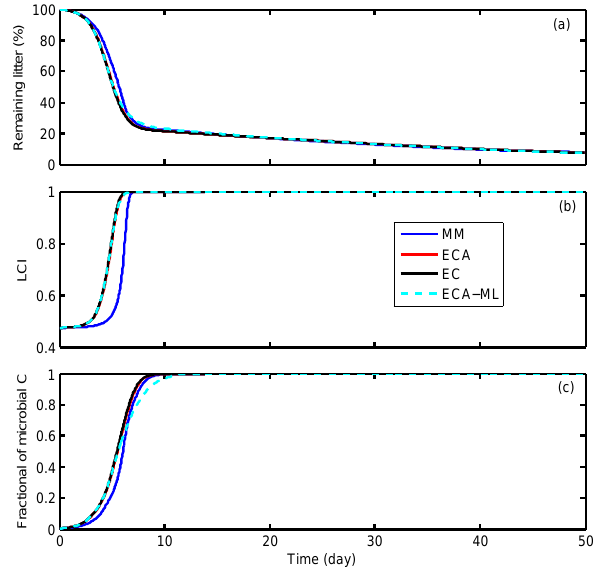
Fig. 6. Time series of the relevant state variables simulated from the applications of the four different substrate uptake kinetics to microbial model S3B1M1.